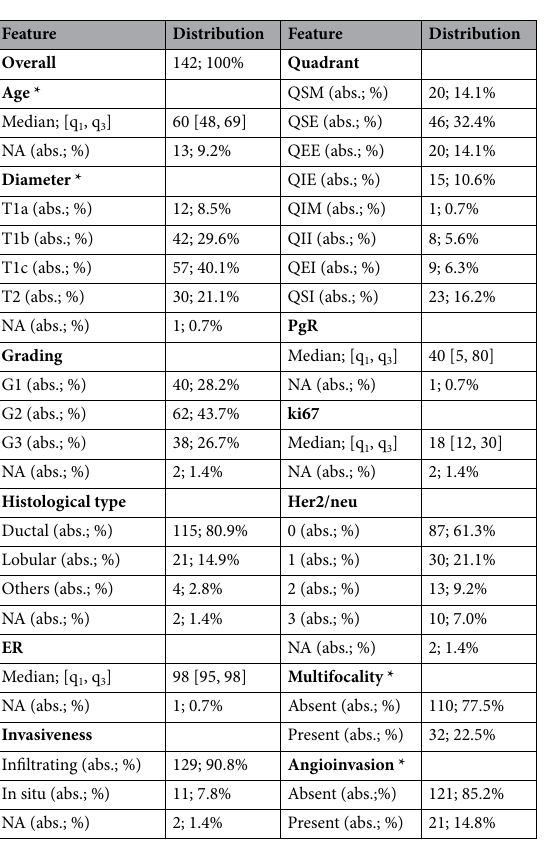
Table 1. Clinical features distribution over the study population. The asterisk * highlights features with a p -value less than 0.05. The statistical analysis was performed by means of the Mann–Whitney test for variables measured on a continuous scale and the Chi-square test for variables measured on a nominal